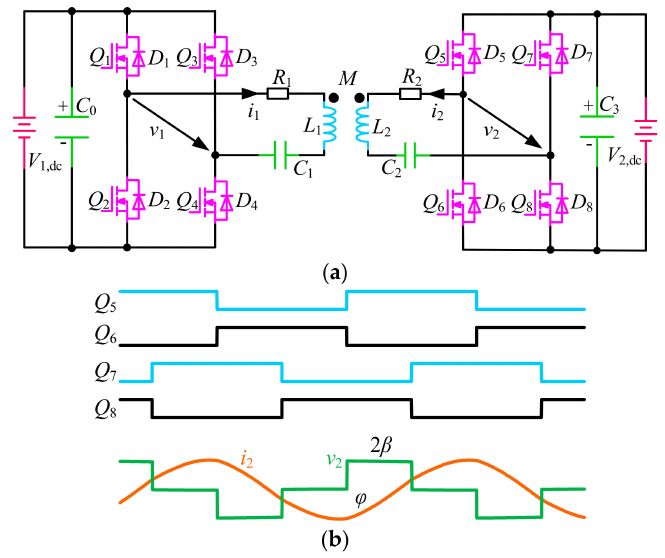
Figure 1. Dual active bridge (DAB) wireless power transfer (WPT) system. ( a ) System schematic; ( b ) Ideal waveforms with zero dead